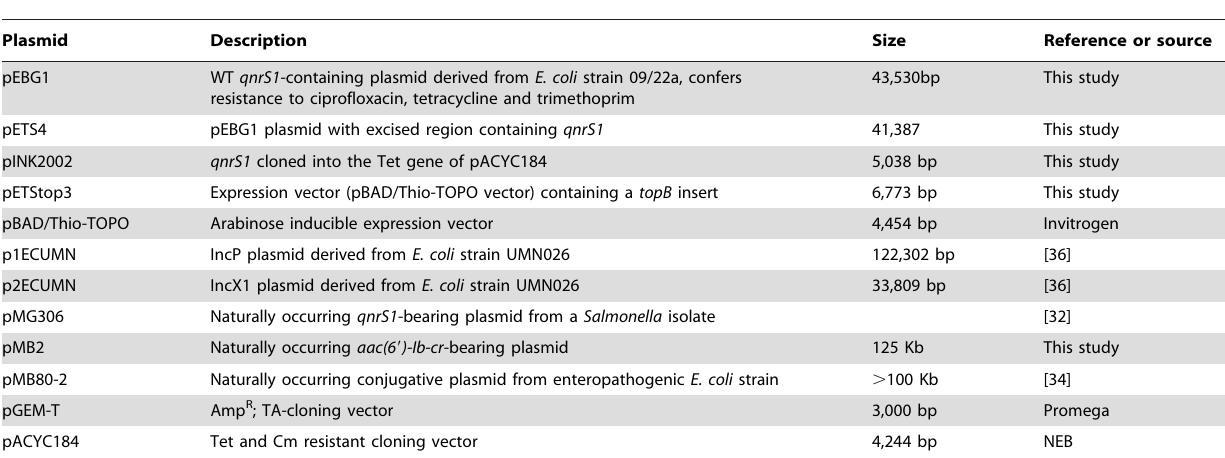
Table 3. Plasmids used in this